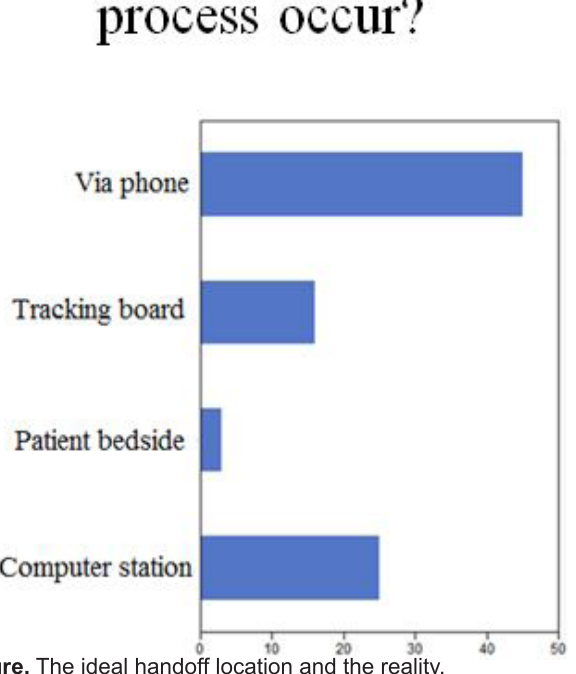
Figure. The ideal handoff location and the